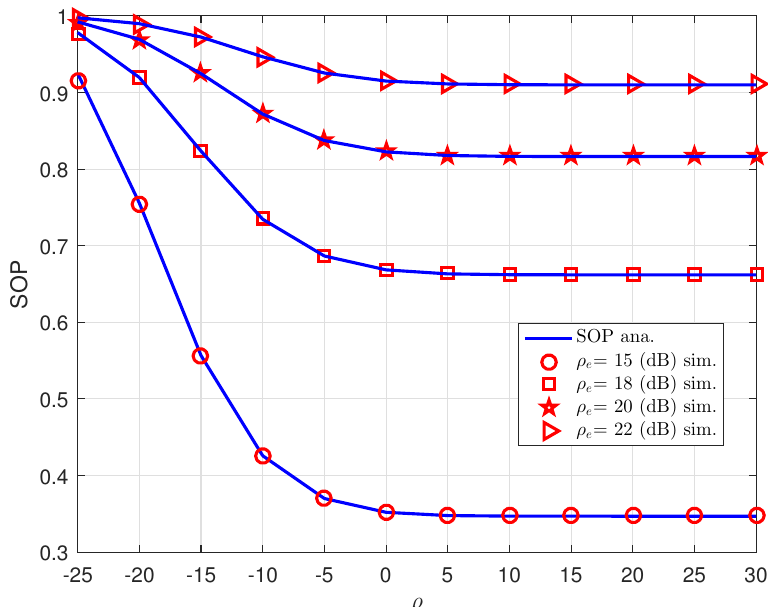
Figure 10. SOP versus ρ for different ρ e .